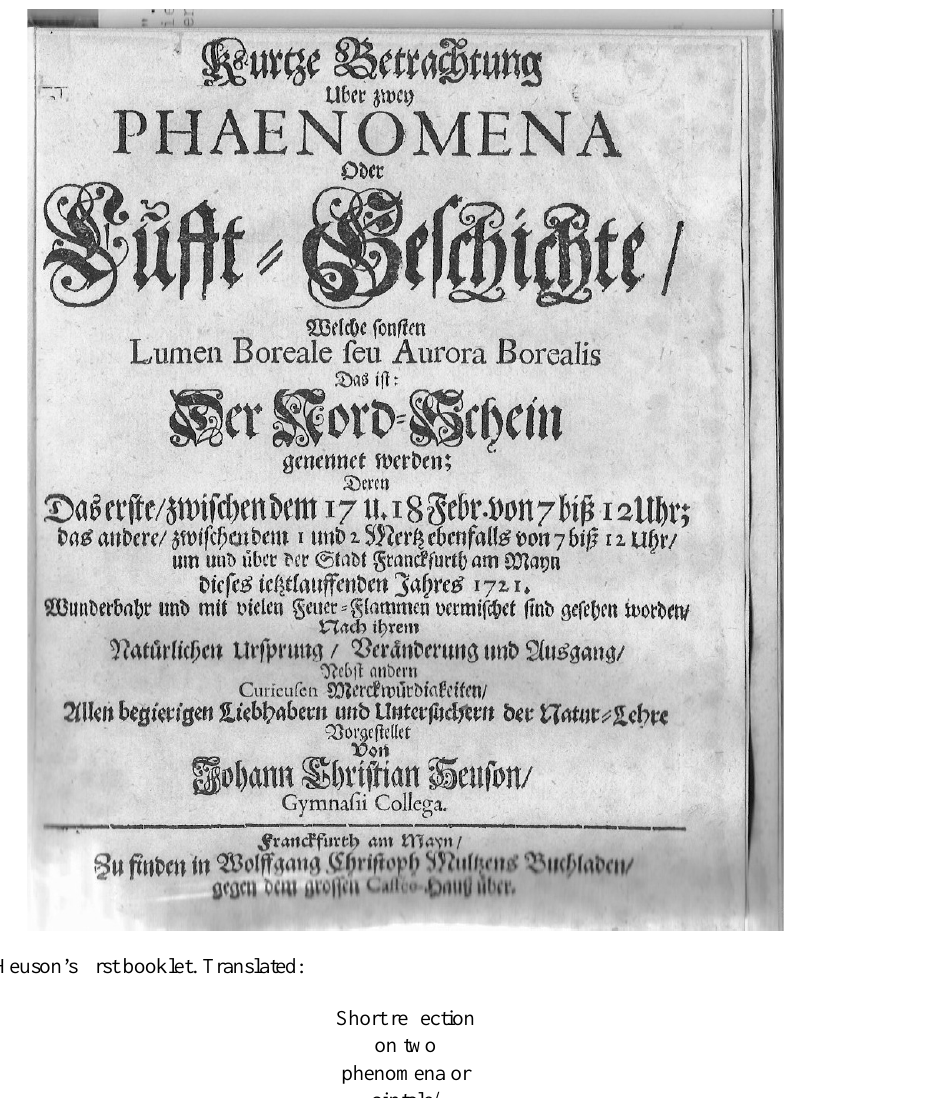
Short reflection on two phenomena or air tale / which otherwise lumen boreale or aurora borealis that is: the northern glow are named; from